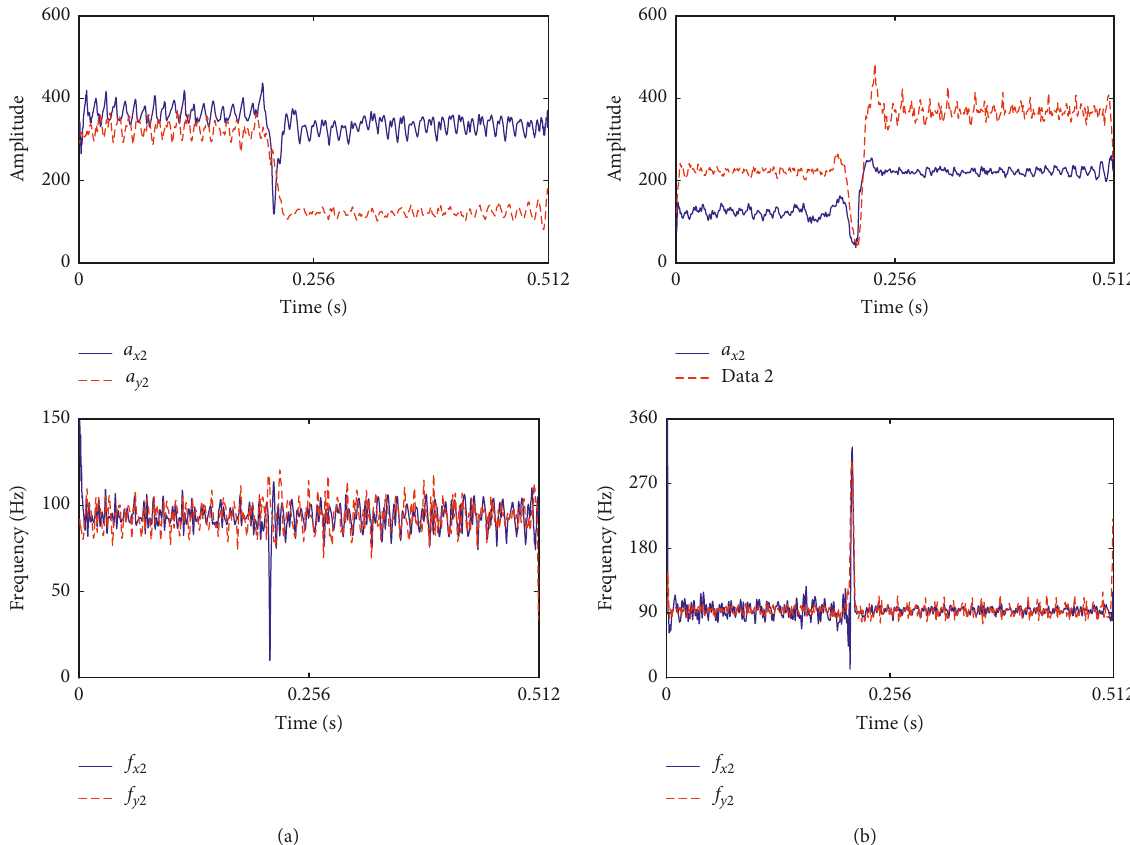
Figure 26: The instantaneous amplitude and frequency of c